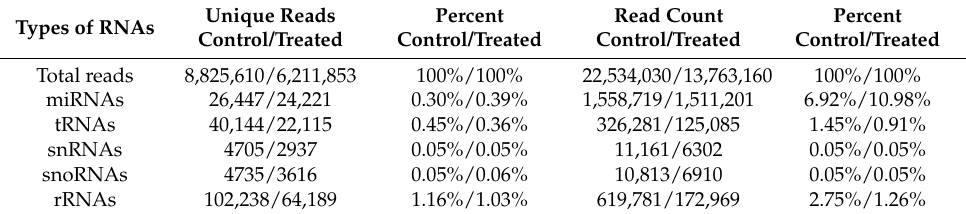
Table 1. Mapping statistics of reads in control versus imidacloprid-treated L. decemlineata